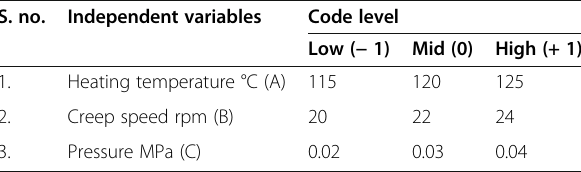
Table 1 Independent variables and levels of experimental design